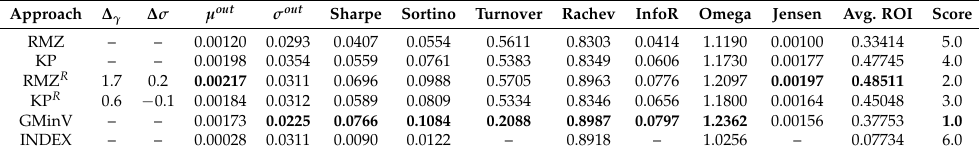
Table 5. Summary of results for ES50.